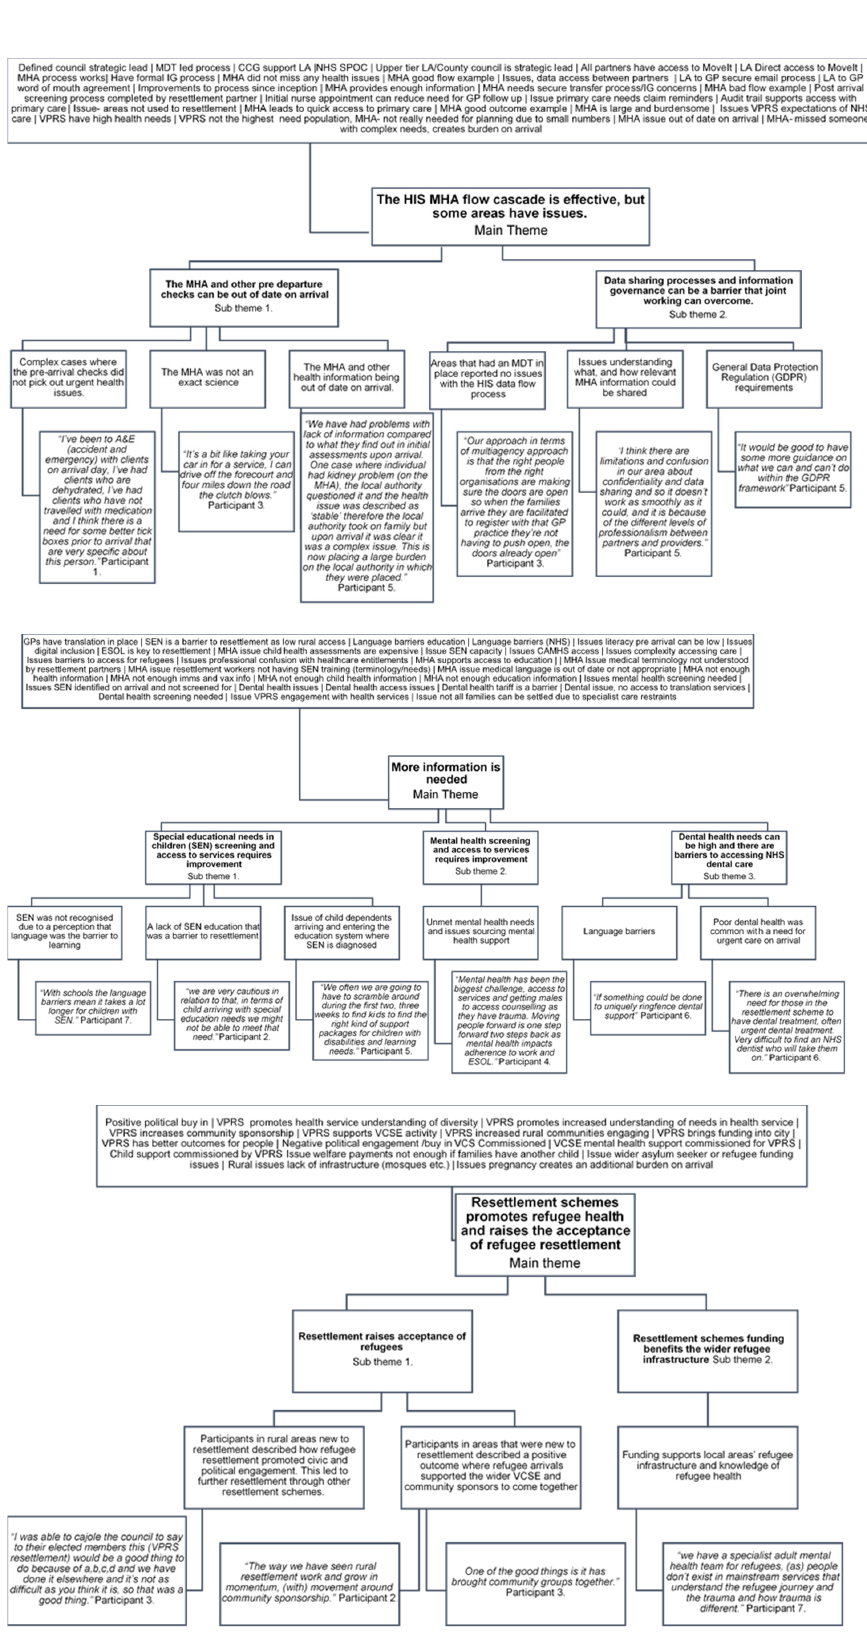
Figure A1. Coding and Theming Trees.